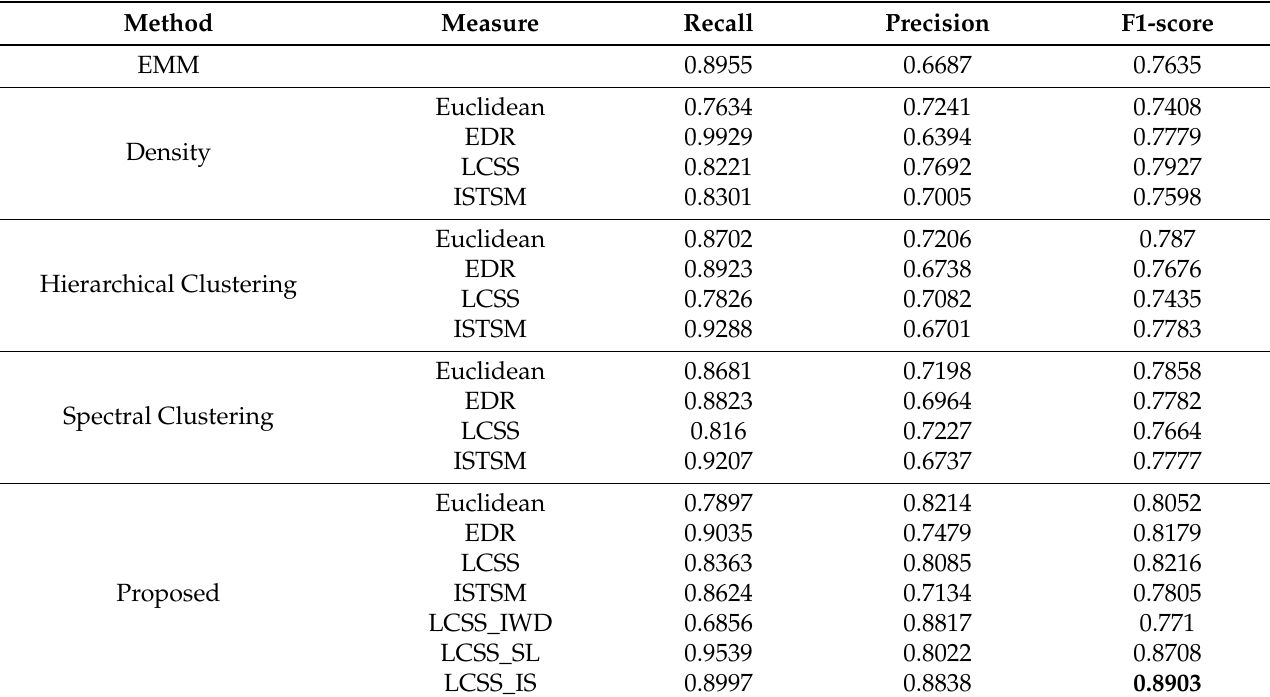
Table 2. Results with anomaly as pricing